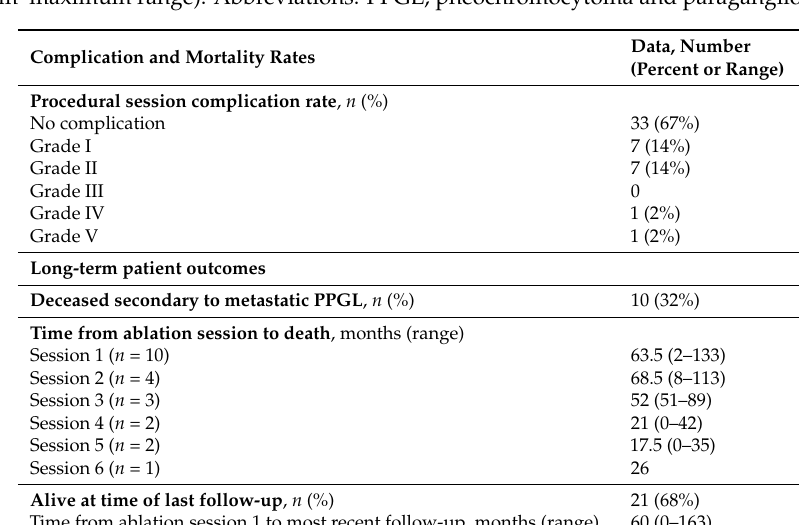
Table 4. Procedure-related complications and long-term mortality data of patients with metastatic pheochromocytoma and paraganglioma treated with ablative therapy. Procedural session complications were graded according to the revised Clavien–Dindo classification